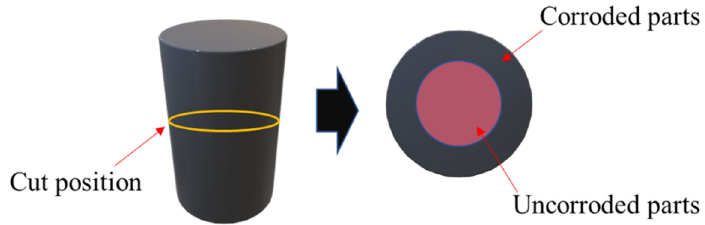
Figure 2. Process of corrosion depth test.